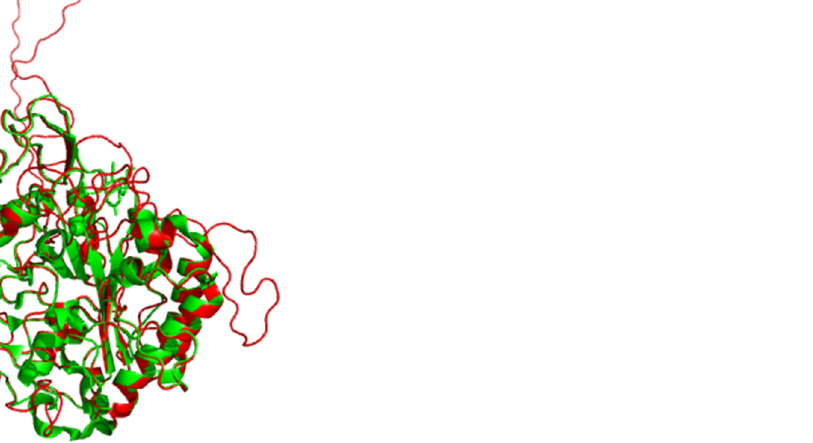
Figure 4. Ramachandran, the Bombyx-Aedes Model terrain. The most favorable regions are shown in dark green, neutral in light green, and non-favorable in white; each amino acid residue is marked with different colors, generated by the structure assessment program (https://swiss- model.expasy.org/assess/KGJVtX/01, accessed on 27 June 2021). 2.3.1. Selection, Validation, and Virtual Screening for Potential Dual Inhibitors The molecular adjustment was performed using the AutoDock Vina program, and all parameter values were adjusted throughout the process to define receptors, exhaust- iveness, center_xyz, and size_xyz. To generate the result in binding affinity values, the AutoDock Vina program foresees the connection of the lowest energy state at the time of the formation of the protein complex (receptor) with the ligand, with the objective of a correlation between the values of the functions and the affinity of the ligand [52–55]. Among the 4793 compounds prioritized in the virtual pharmacophore-based screening of the Zinc15 database, 4142 compounds (  G < 0 kcal/mol) were aligned to the binding site of the crystalline structure of the juvenile hormone protein macromolecules (code PDB: 5V13) of Aedes aegypti ; its complexed binding site has the reference ligand JH3 (methyl